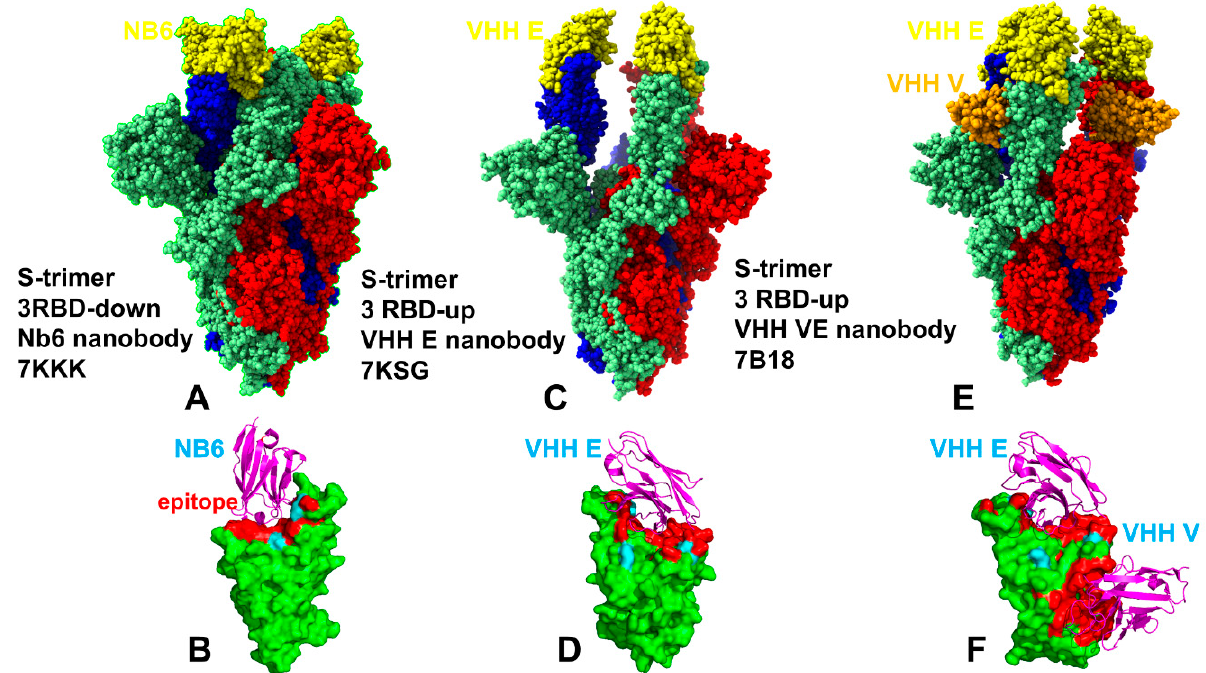
Figure 1. Cryo-EM structures of the SARS-CoV-2 S trimer complexes with a panel of studied nanobodies. ( A ) The structure of the SARS-CoV-2 S trimer in the complex with Nb6 nanobody, pdb id 7KKK. Nb6 nanobodies are shown in yellow spheres. ( B ) The S-RBD bound to Nb6. The S-RBD structure is shown in green surfaces. The binding epitope residues of the S-RBD bound structures are shown in red. The sites of circulating mutations K417, E484, and N501 are highlighted in cyan surfaces. Nb6 nanobody is in magenta ribbons. ( C ) The structure of the SARS-CoV-2 S trimer in the complex with VHH E nanobody, pdb id 7KSG. VHH E is in yellow spheres. ( D ) The S-RBD (in green surface) bound to VHH E (magenta ribbons). The binding epitope residues of the S-RBD bound structures are shown in red. The sites of circulating mutations K417, E484, and N501 are